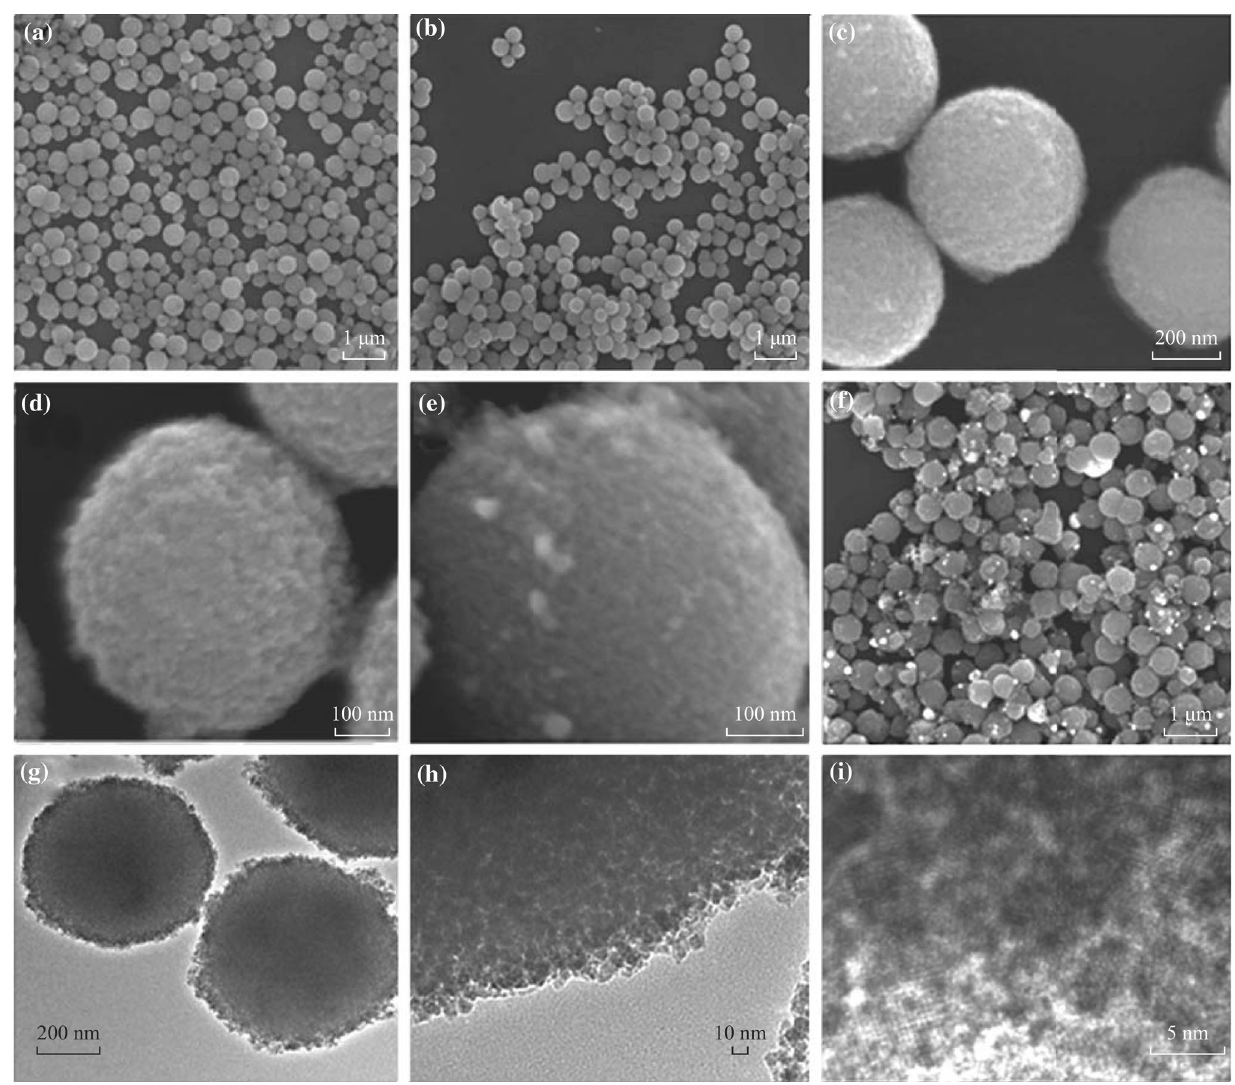
Fig. 3 FE-SEM images of Ag–AgBr@TiO 2 NPAS: a S8, b S9, c S10, d S12, e S13, f S14 and g – i TEM and HRTEM images of sample